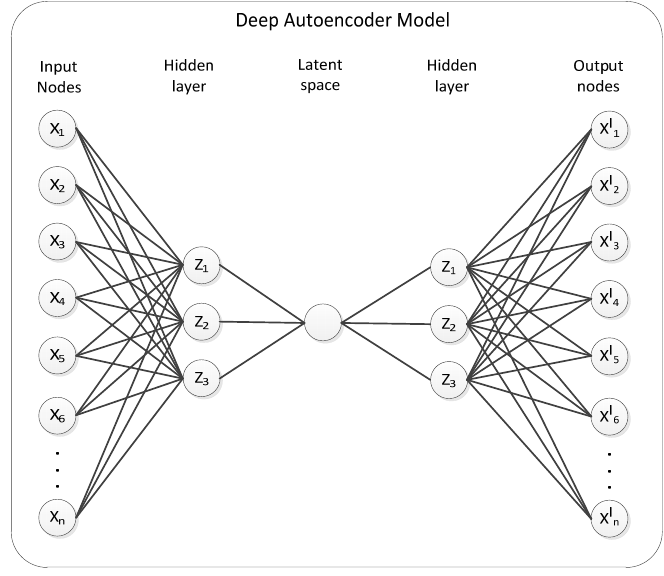
Figure 2. Deep autoencoder model.